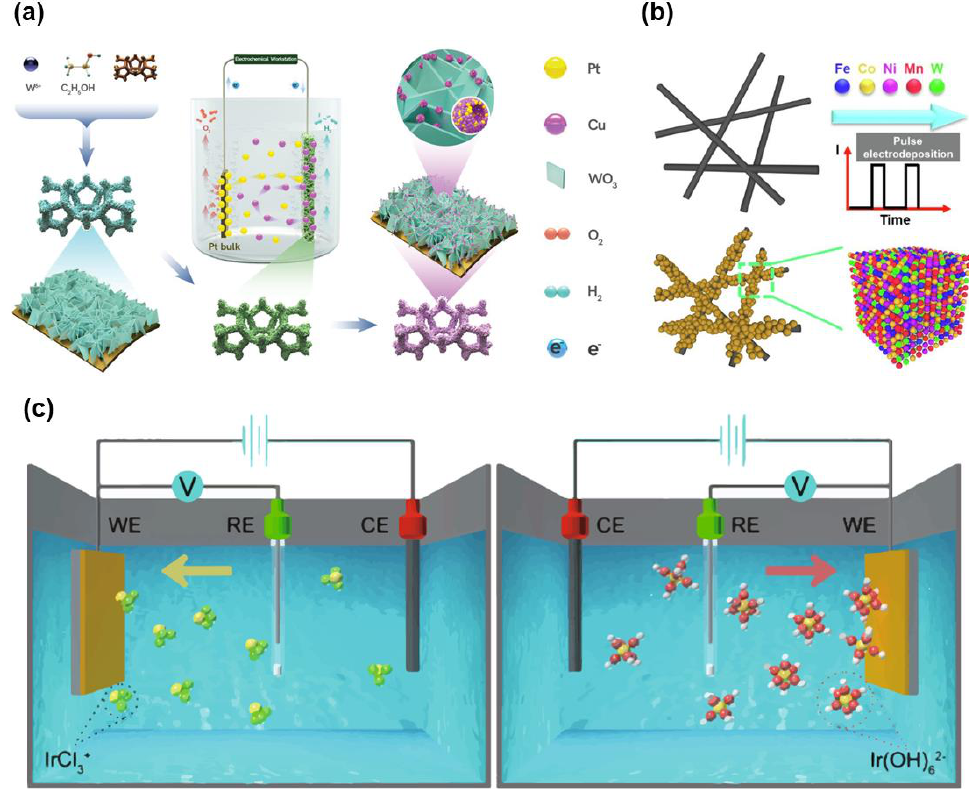
Figure 1. Schematic illustration of ( a ) the preparation of PtCu/WO 3 @CF (Pt loading: 0.0043 mg/cm 2 ). Reprinted (adapted) from [109], copyright (2021) Wiley-VCH GmbH. ( b ) Fabrication of H-FeCo- NiMnW. Reprinted (adapted) from [110], copyright (2023) Elsevier B.V. ( c ) Electrochemical deposition of Ir species cathodic deposition and anodic deposition. Reprinted (adapted) from [111], copyright (2023) Springer Nature Limited.